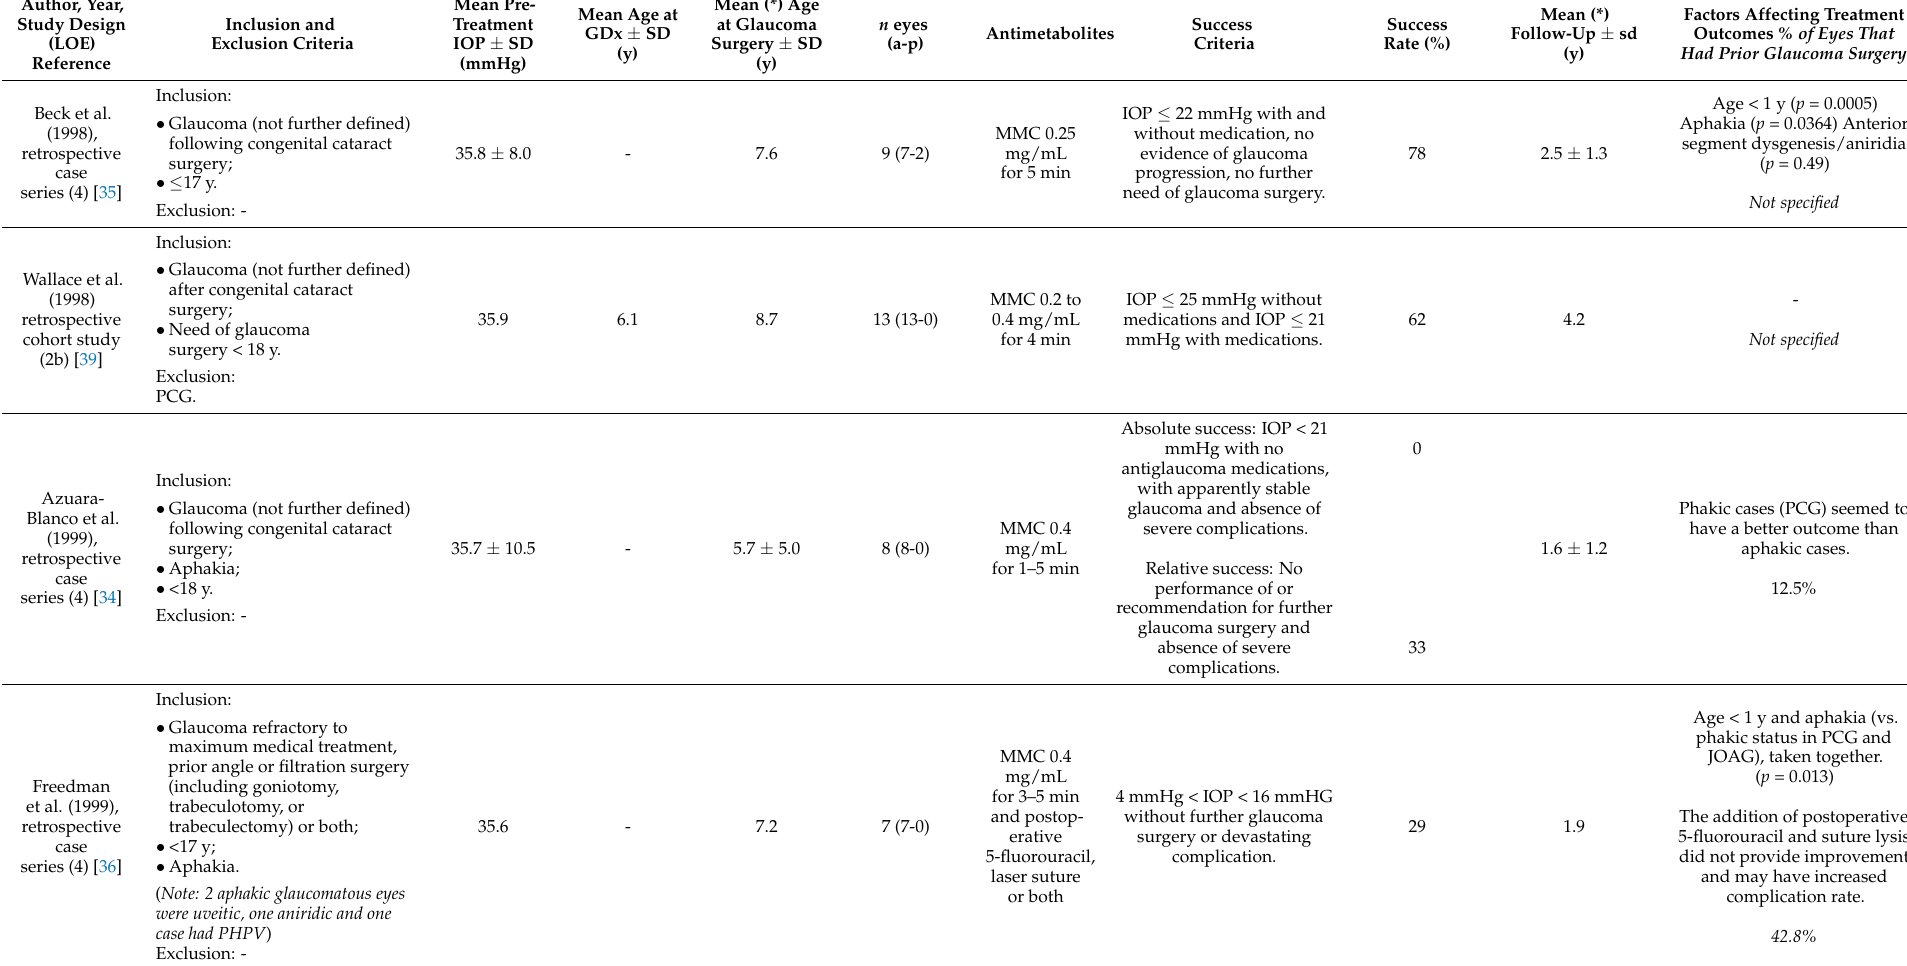
Table 3. Relevant studies involving trabeculectomy in GFCS